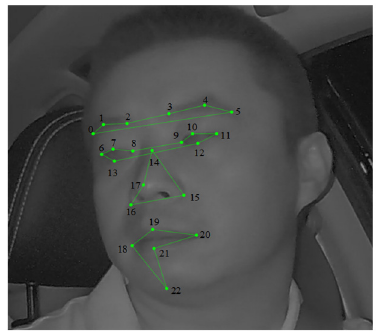
Figure 4. Annotation map of 23 key points on the face.